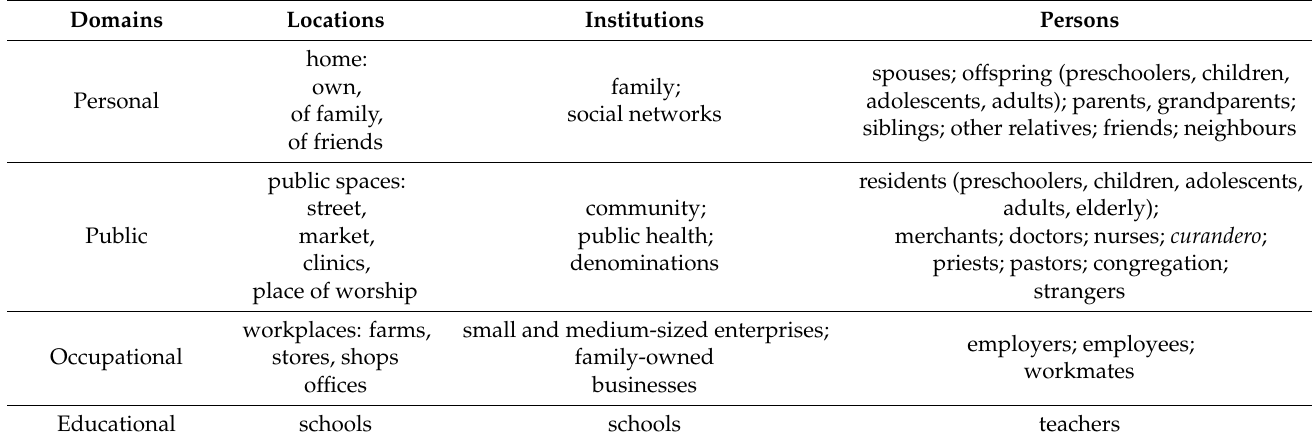
Table 1. External context of language use in Santiago